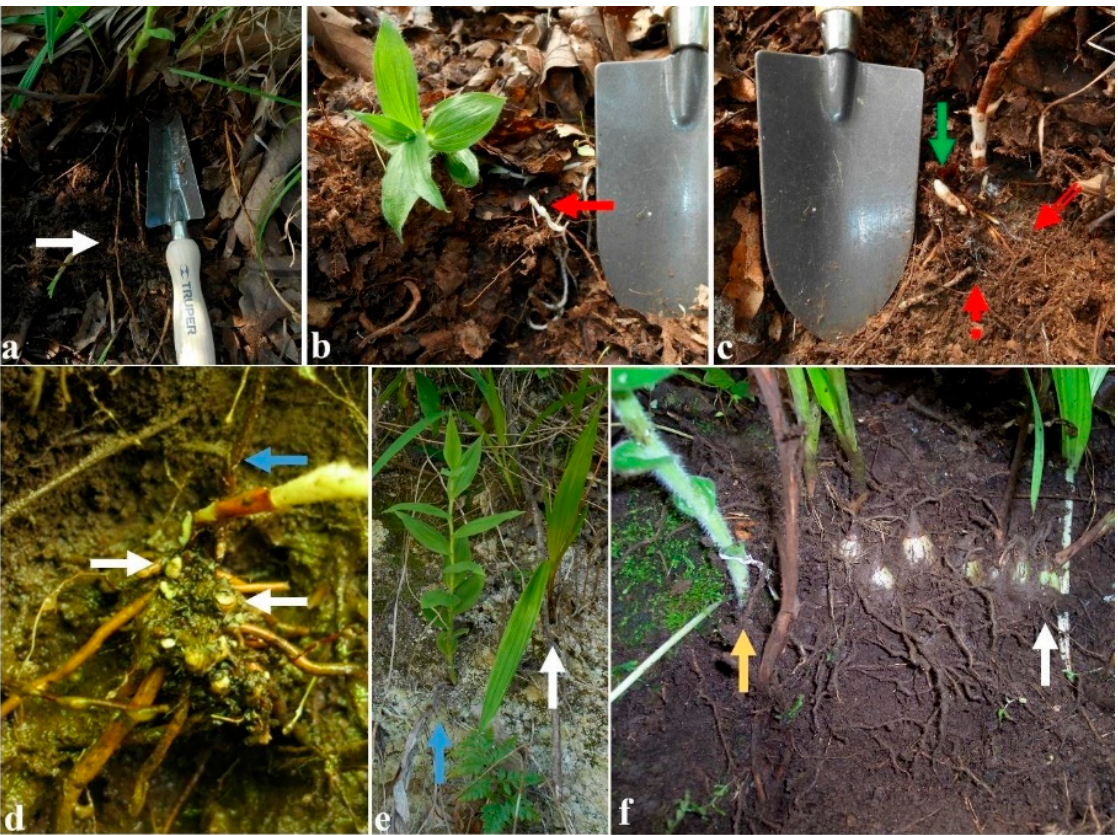
Figure 5. In situ development of Cypripedium molle ( a , b ) in an oak forest in Oaxaca State and C. irapeanum ( c – f ) in an oak forest in Mexico State and in a tropical dry forest in Veracruz State. ( a ) Long, little-branched roots longer than 30 cm under abundant litter (white arrow). ( b ) Achloro- phyllous shoot (red arrow) of an emerging plant sprouting due to the deep litter where roots develop in the humic horizon. ( c ) Lateral shoot emerging from a near meristematic node (green arrow) and short rhizome development with roots surrounded by mycelial cords (dashed red arrow) with short-distance exploration mycelium (double-line red arrow). ( d ) Multiple points of emergence of annual plants showing a node with growth of several years (white arrows) and the remainder of a dried shoot from the previous year (blue arrow). ( e ) Plants usually associated with Bletia orchids ( B. purpurea , white arrow). ( f ) Association with an eight-year-old Bletia punctata plant showing the emerging shoots of the first two submerged bulbs. These belong to the first and second bulbs that developed after germination and the emerging shoots after eight years (white arrow). A dried C. irapeanum shoot from the previous year next to a new emerging shoot (yellow arrow). Photos taken by Mauricio Moreno in the year 2019.